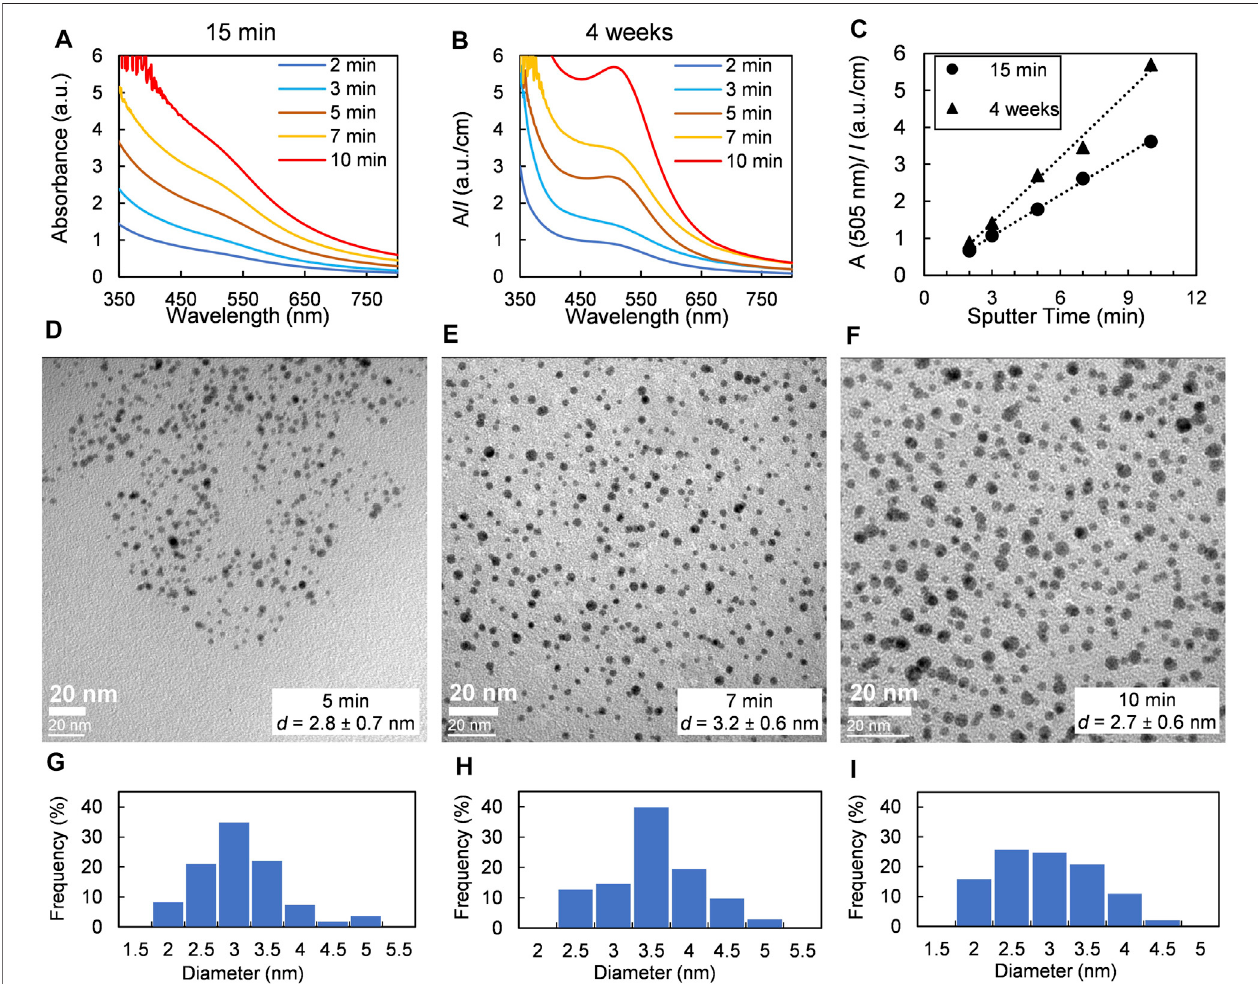
FIGURE 2 | Effect of sputter time: samples were obtained at a fi xed argon pressure of 0.07 Pa and an applied power of 80 W. (A) and (B) UV-vis spectra of dispersionsofAuNPsincastoroilrecorded15 minand4weekslaterafterdeposition,respectively. (C) ChangesinabsorbanceatthemaximumofSPRbandofAuNPs. (D – F) TEM images and (G – I) size distributions of Au NPs obtained at sputter time of 5, 7, and 10 min,